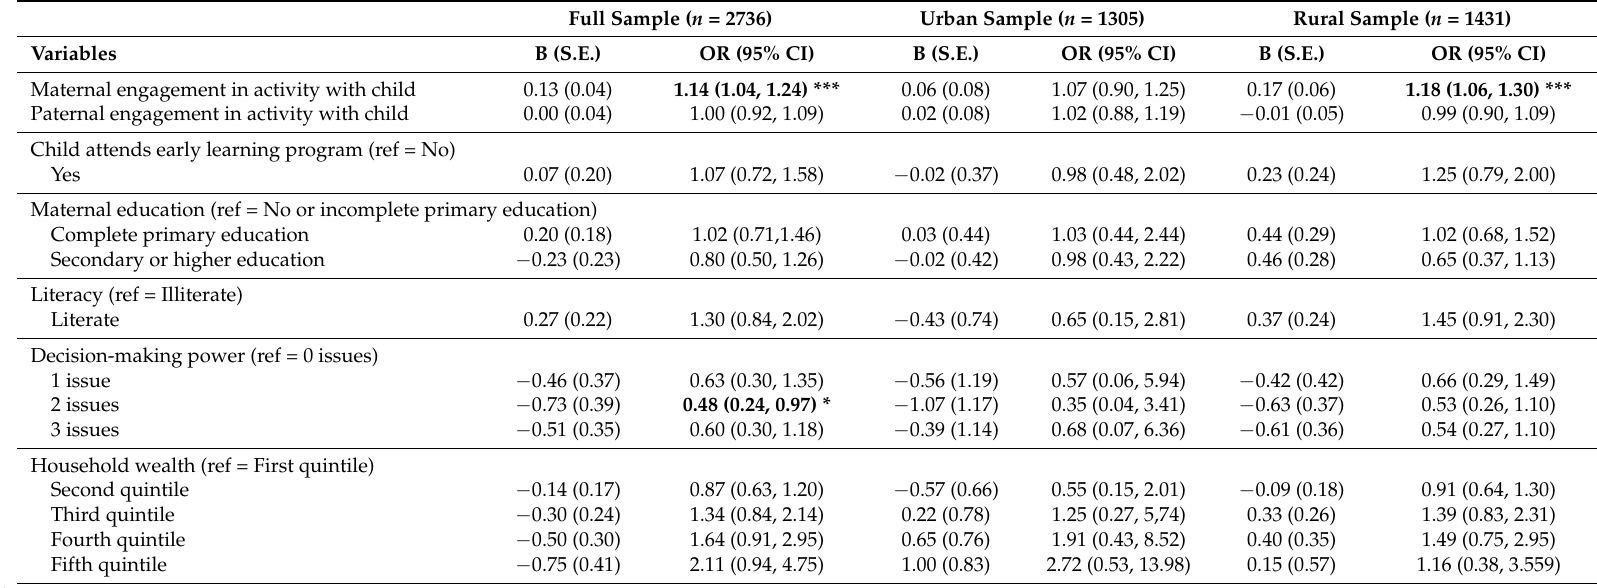
1 All analyses are adjusted for maternal age, maternal marital status, geographic region, number of children <5 years living in household, and child age and sex. r2 model fit estimates = 0.03–0.06, 0.03–0.07, and 0.03–0.05 for full, urban and rural sample respectively. B indicates regression coefficient; S.E. indicates standard error of B; OR indicates odds ratio; CI indicates confidence interval; ref indicates reference category. OR with CI not including 1 are indicated in bold. *** p ≤ 0.001, * p ≤